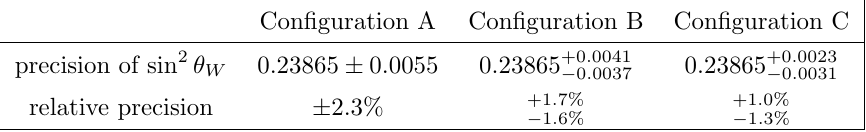
Table 2 . Precision of the sin 2 θ measurement in the three 51 Cr-LXe configurations W